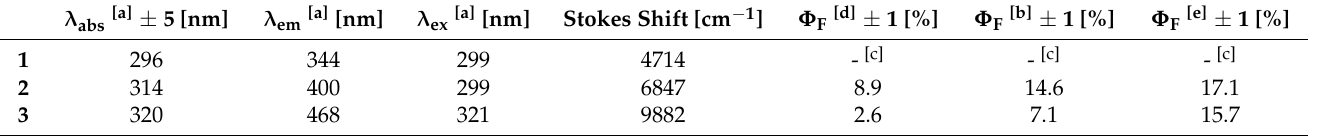
Table 1. Overview over spectroscopic parameters obtained from compounds ( 1 )–( 3